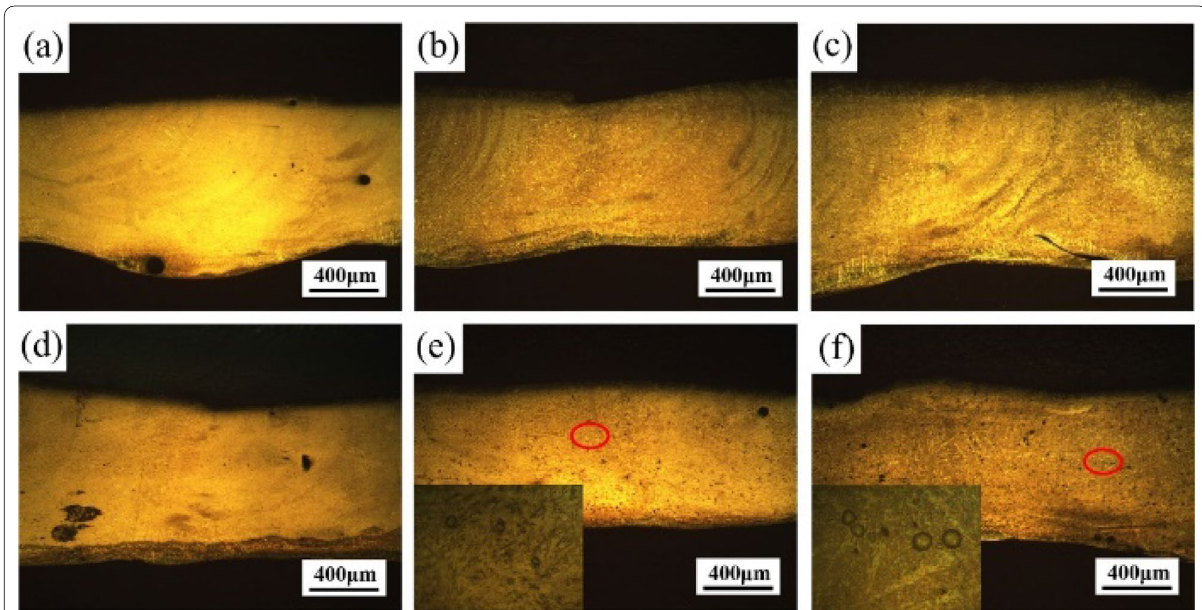
Figure 5 Cross-section morphology of nickel-based composite coating with the addition of stainless steel net: ( a ) Ni60 coating coating